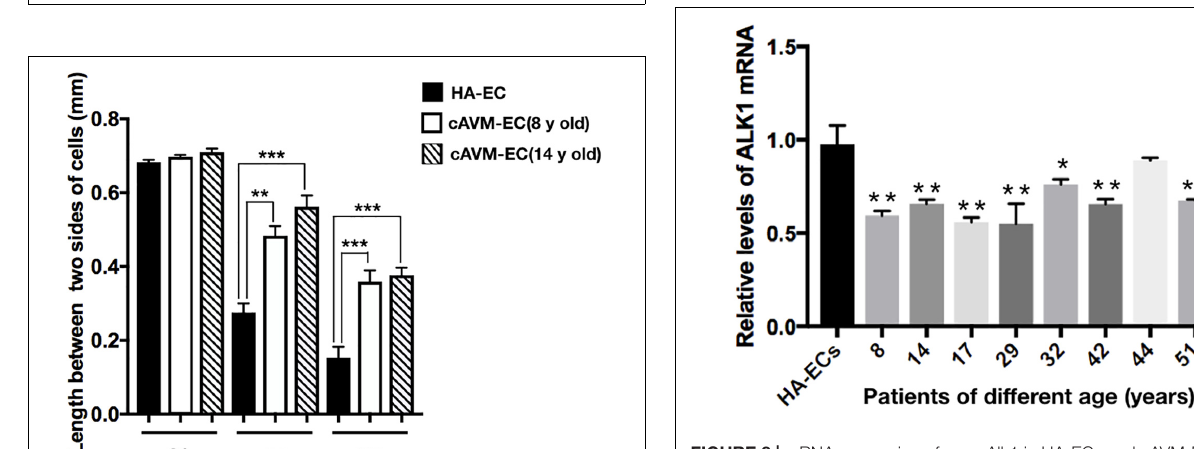
FIGURE 8 | mRNA expression of gene Alk1 in HA-ECs and cAVM-ECs in patients with different ages. Levels of VEGF-A mRNA expression (0.986 ± 0.134) in the HA-ECs were lower than that in cAVM-ECs (8 years) (4.183 ± 0.238) and cAVM-ECs (14 years) (3.834 ± 0.451) (all ∗ p < 0.05). In addition, the levels of VEGF-A mRNA expression were (2.92 ± 0.58) in cAVM-ECs (17 years), (3.04 ± 0.79) in cAVM-ECs (29 years), (3.08 ± 0.37) in cAVM-ECs (32 years), (2.08 ± 0.28) in cAVM-ECs (42 years), (1.97 ± 0.24) in cAVM-ECs (44 years), and (1.97 ± 0.25) in cAVM-ECs (51 years), all of that were higher than that (0.986 ± 0.134) in HA-ECs (all ∗ p < 0.05). cAVM-ECs (0.3437 ± 0.02426) was smaller than that in HA- ECs (0.4557 ± 0.01356), and there was significant difference ( p < 0.05) ( Figure 3 ). These results showed that obvious changes existed in the morphology of